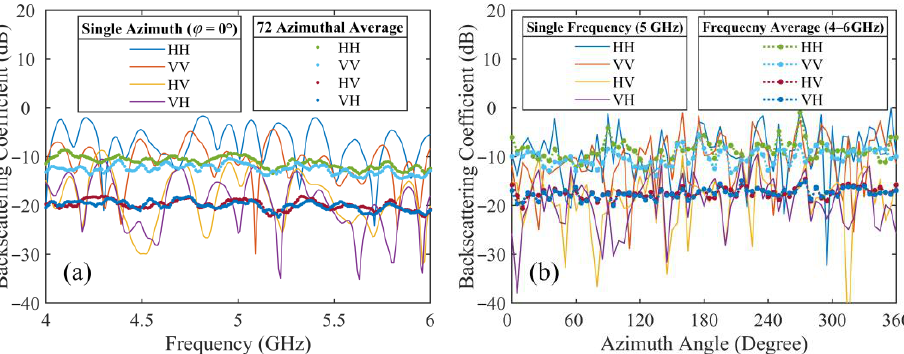
Figure 14. Backscattering coefficient results of rice field Scene 2 after ( a ) spatial and ( b ) frequency averaging at an incidence of 40°.